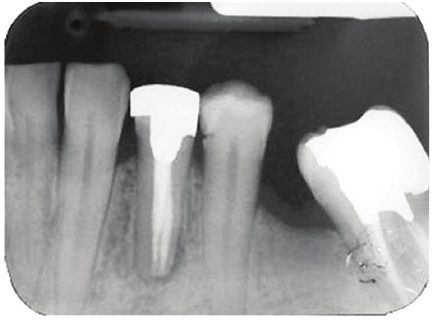
Figure 5: A 1-year recall shows complete